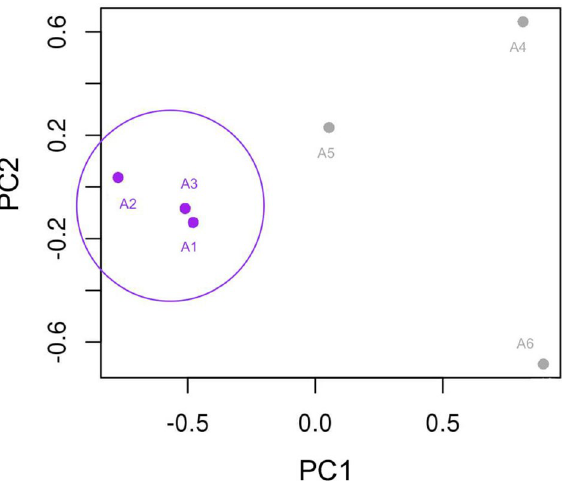
Figure 4. MDS plot realized with R Studio (https:// www. rstud io. com/ produ cts/ rpack ages/), showing the cluster of the affected cats, based on the 258 miRNAs expression (log2 counts per million). Affected individuals (purple) are grouped on the left, while the healthy individuals are represented by grey dots on the